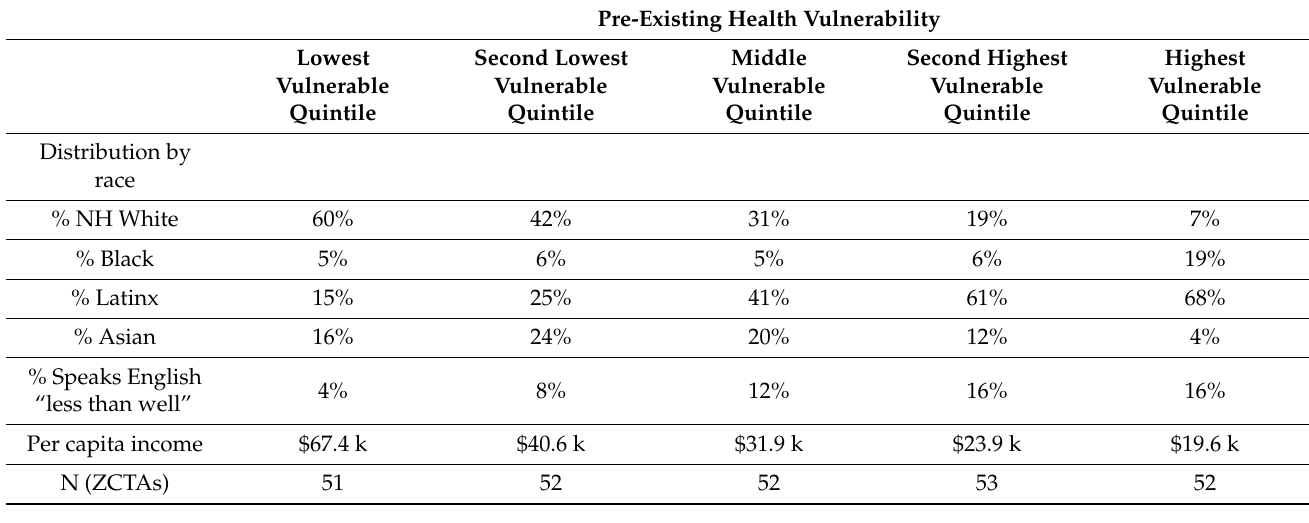
Table 1. Neighborhood socio-demographic characteristics by level of pre-existing health vulnerability.